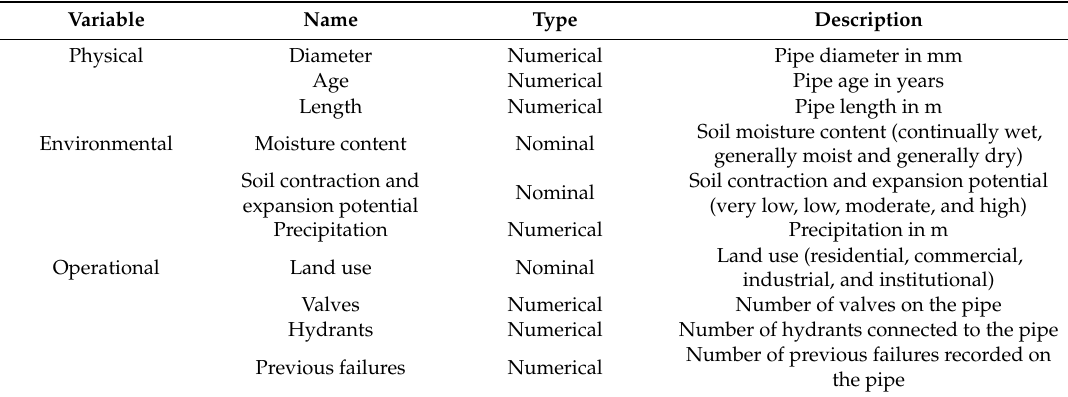
Table 1. Explanatory variables for Machine Learning (ML)